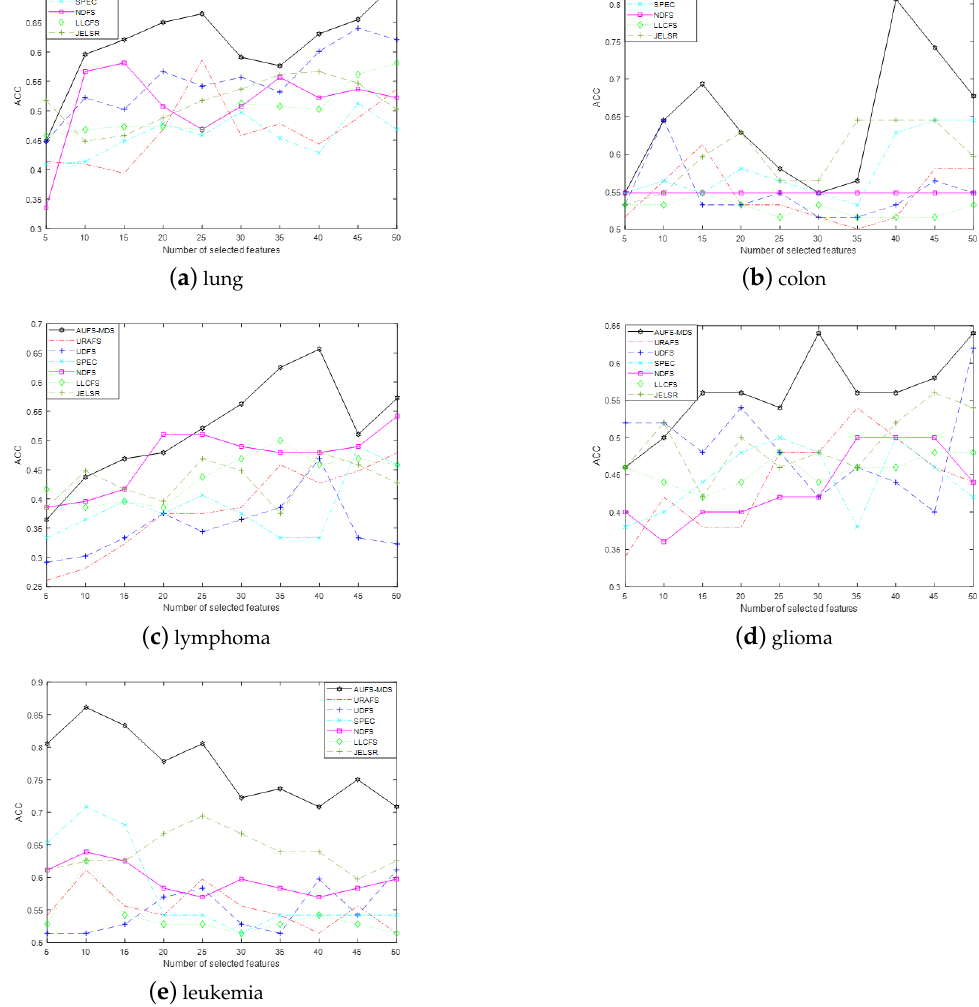
Figure 2. Clustering accuracy of all the methods on five different datasets.